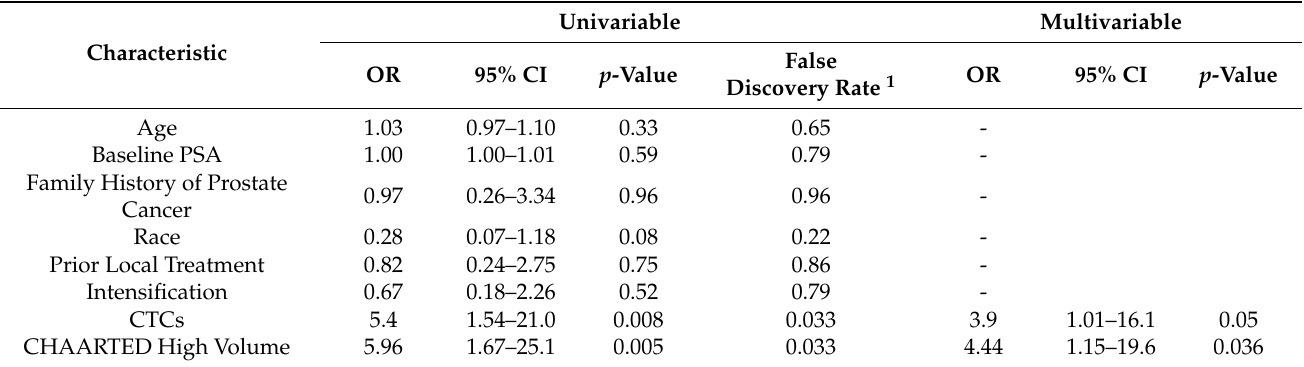
Table 3. Univariable and multivariable logistic regression model for disease